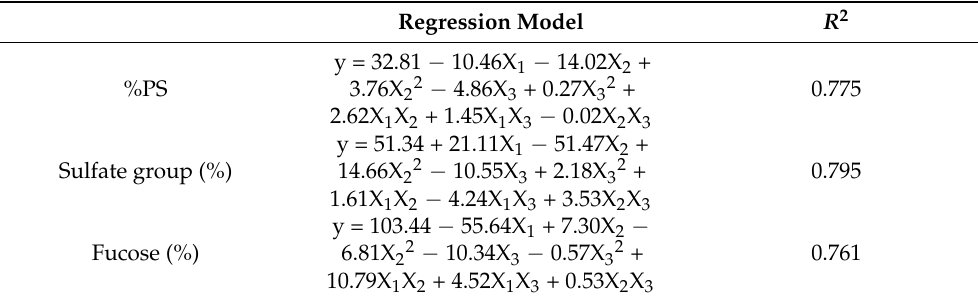
Table 3. Regression model equations and determination coefficients ( R 2 ) for polysaccharide yield (%PS), sulfate group, and fucose